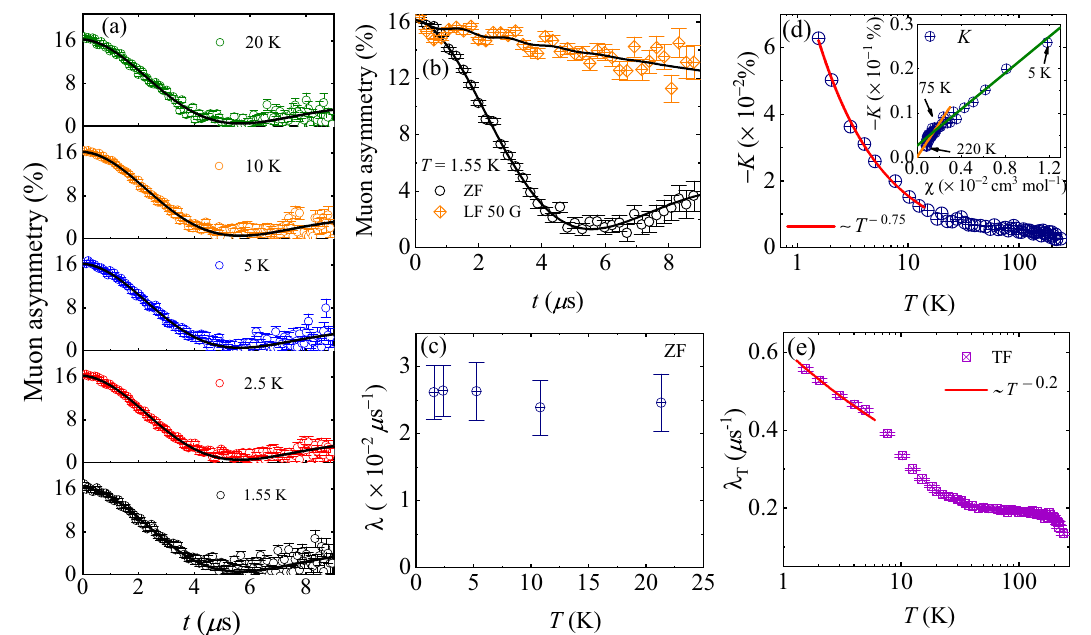
Fig. 4 Muon spin-relaxation results reveal a spin-liquid state in Li 4 CuTeO 6 . a The time evolution of zero- fi eld muon spin asymmetry curves for several temperatures where solid lines are the fi ts to Eq. (3). b The time evolution of muon spin asymmetry in zero fi eld and in a longitudinal fi eld (LF) of 50 G at 1.55 K with fi ts as discussed in the text. The simultaneous fi t of zero- fi eld and longitudinal fi eld data to the Eq. (3) yields σ = 3.66 G and λ = 0.029 μ s − 1 . c The temperature dependence of the longitudinal muon spin-relaxation rate in zero fi eld. d The temperature dependence of Knight shift where red line is the fi t of low-temperature Knight shift i.e., K ~ T − γ with γ = 0.75 in the applied fi eld of 4900 G. Inset shows the scaling of the muon Knight shift ( K ) with bulk susceptibility with temperature as an implicit parameter. The solid line is the linear fi t in two regions (see text). e The temperature dependence of the muon relaxation rate in the presence of a transverse fi eld (TF) of 4900 G where the red line is the power-law T − 0.2 fi t in the low-temperature region. Error bars represent uncertainty of one standard